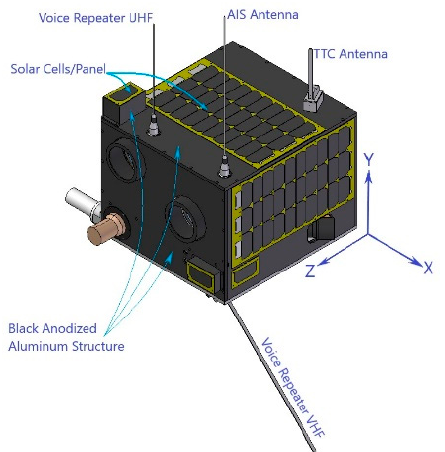
Figure 1. Illustration of the LAPAN-A2 microsatellite.